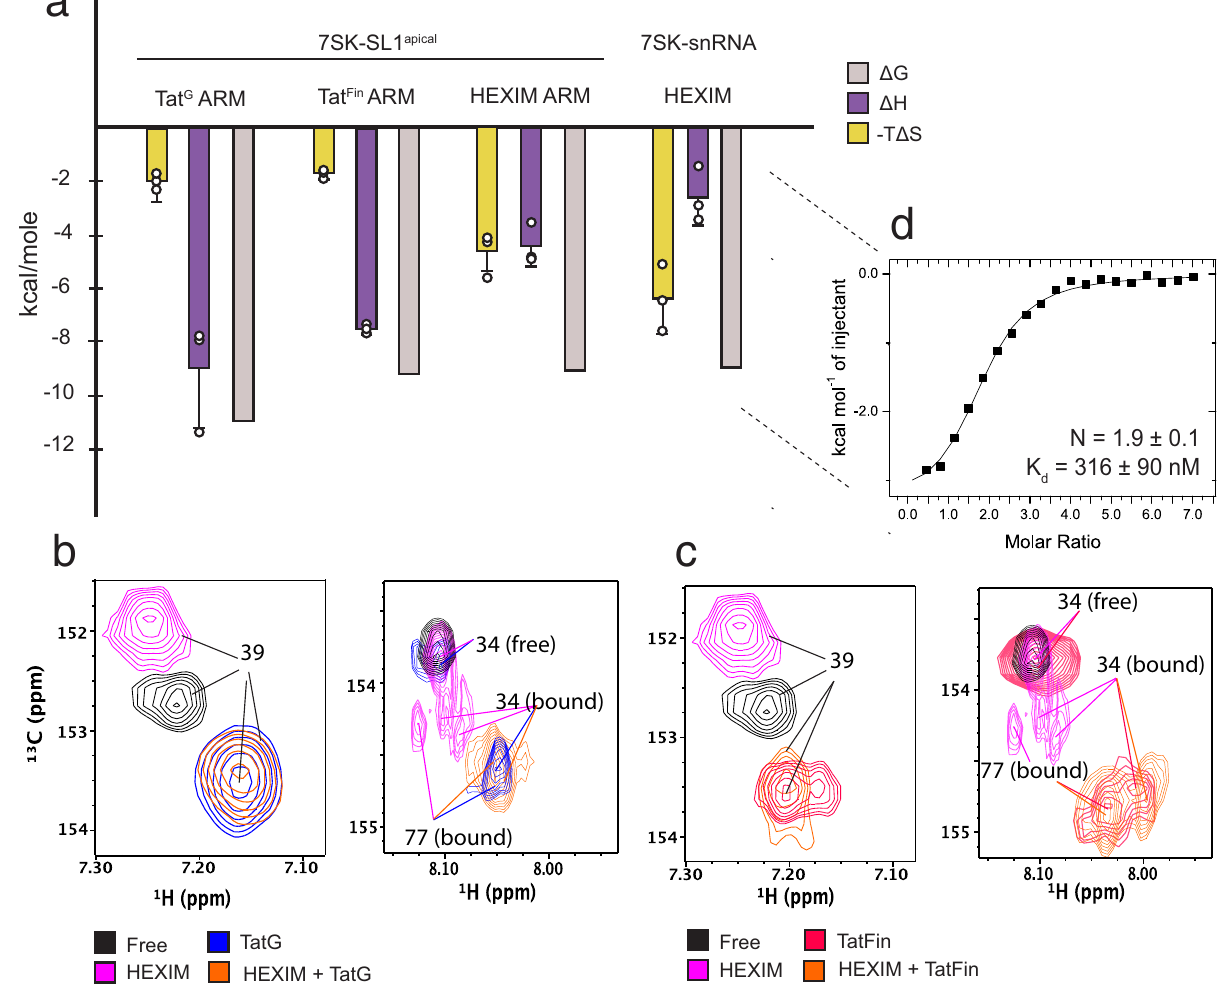
Fig. 4 Comparative thermodynamic analyses and competition experiments between Tat and HEXIM. a Comparison of enthalpic and entropic contributions between Tat G , Tat Fin , and HEXIM N-ARM in complex with 7SK-SL1 apical-AGU , and full-length HEXIM in complex with 7SK snRNA. Entropy values were calculated using a T value of 298 K. The reversal in the entropic and enthalpic contribution for Tat ARM compared to HEXIM is evident with HEXIM having an entropically-driven binding pro fi le. NMR competition titration analysis showing binding of 7SK by Tat G ( b ) and Tat Fin ( c ) concomitant with the total displacement of HEXIM N-ARM . Data are shown for the A 39 (left) and A 34/77 (right) h2-c2 correlations. The increase in Tat engagement of ASM 1 for the HEXIM N-ARM -bound complex is evident by the lack of free-RNA populations for the A 34 resonance in the competition experiment compared to binding to free 7SK. Furthermore, the destabilization of A 34 in ASM 1 by HEXIM is indicated by multiple bound states. Also shown for comparison is the complete engagement of A 39 by all ARMs. d Representative ITC data for full-length HEXIM bound to 7SK snRNP demonstrating expected stoichiometry and speci fi c binding. All reported values are for n = 3